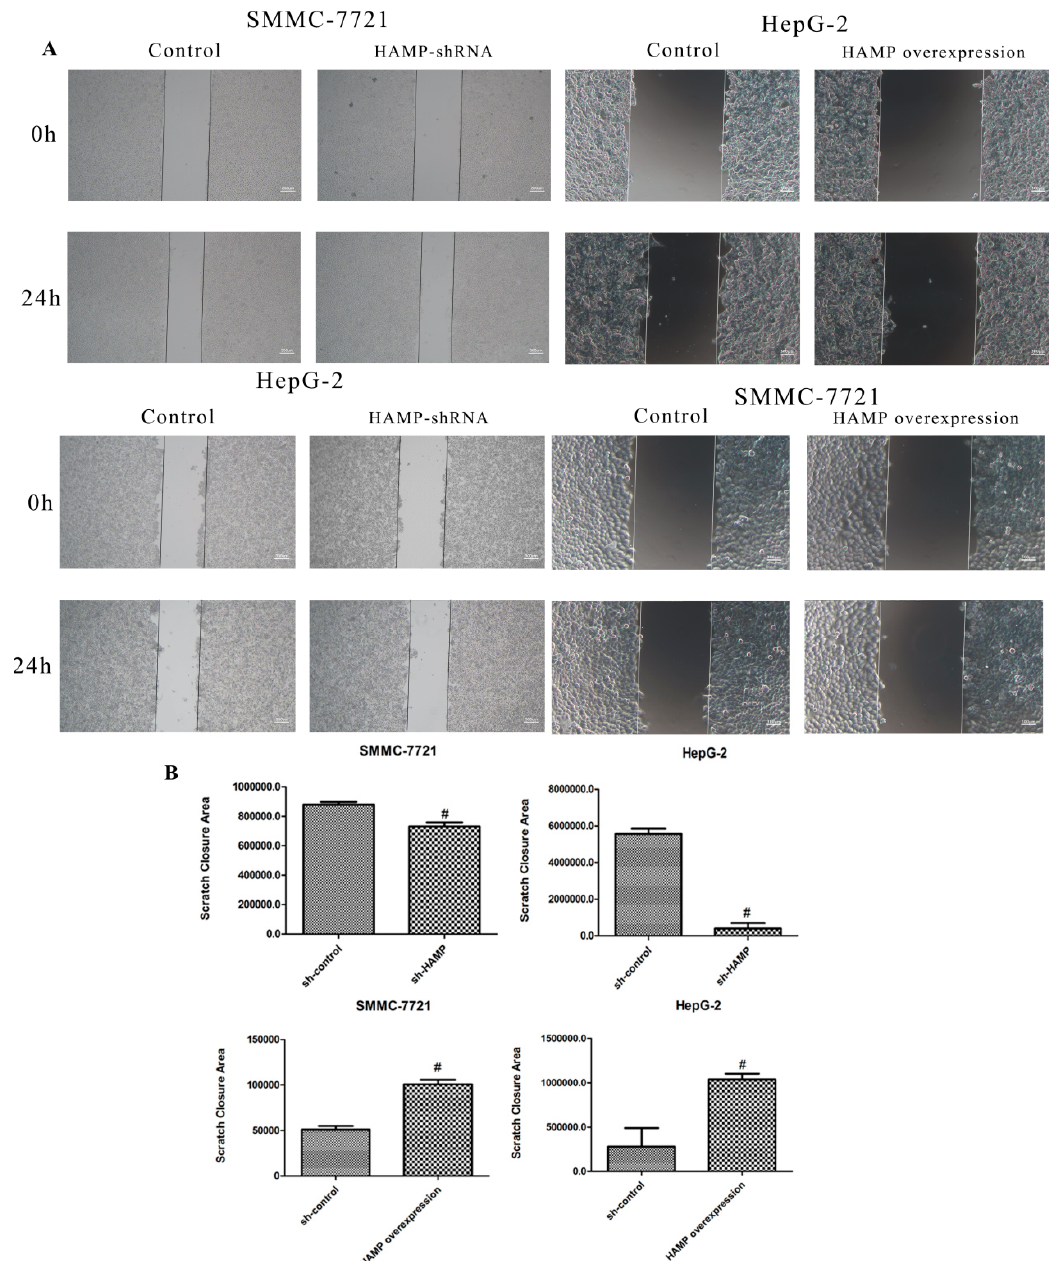
Figure 3. The effect of HAMP on the migration of liver cancer cells. ( A , B ) Migration was measured via wound-healing assay for SMMC-7721/HepG-2 cells transfected with control, HAMP shRNA, and HAMP overexpression vector. # p < 0.05. Scale bar = 300 µM